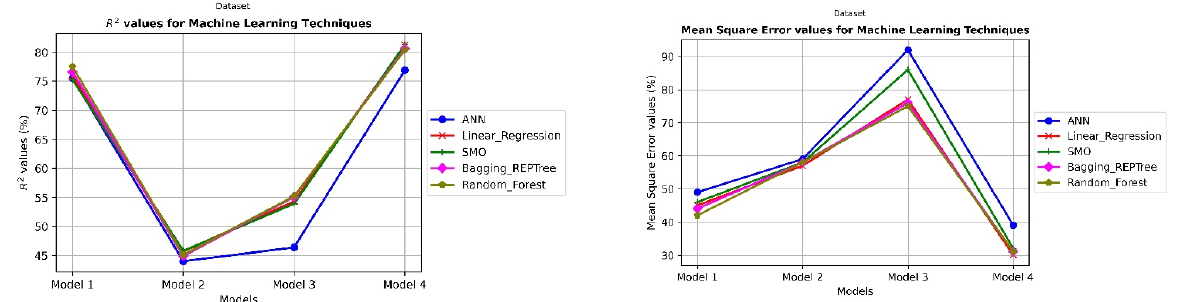
Fig. 2. Results of using ML techniques on E-learning dataset (a) R²; (b)